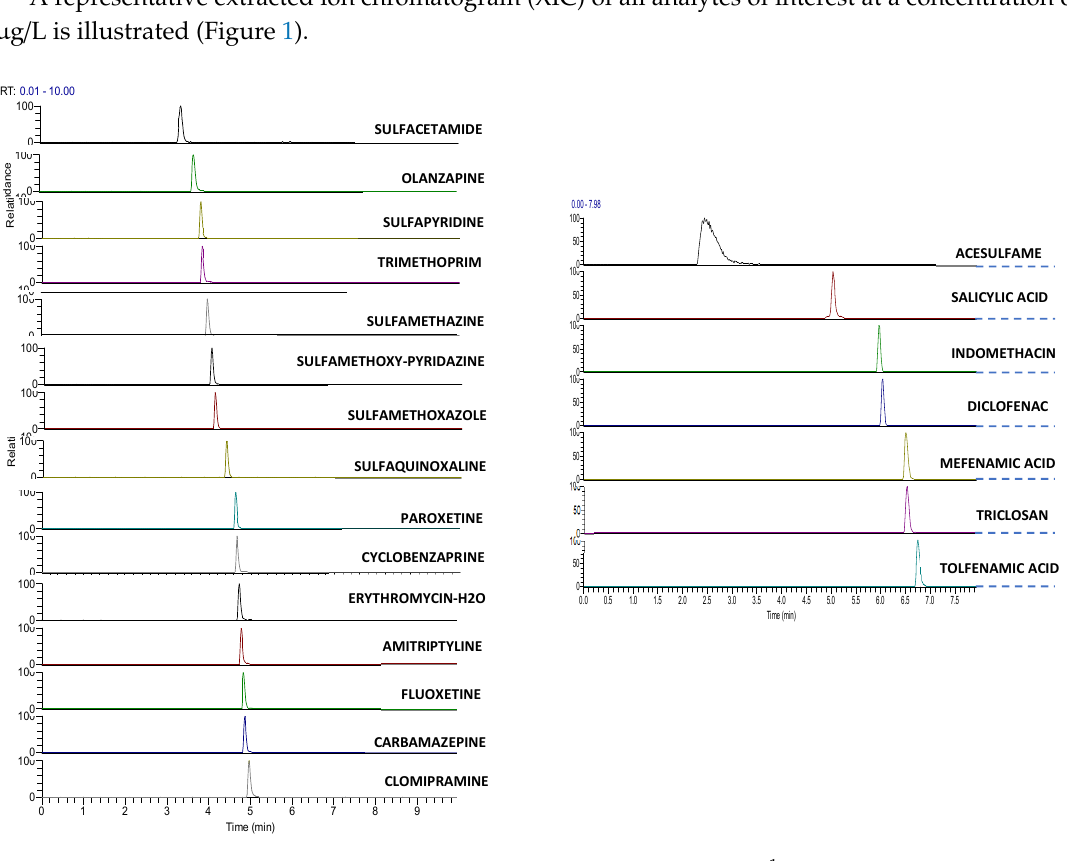
Figure 1. Extracted Ion Chromatogram, XIC of a standard solution of 5 µ g L − 1 in UHPLC–LTQ / Orbitrap of target analytes from left to right positive and negative